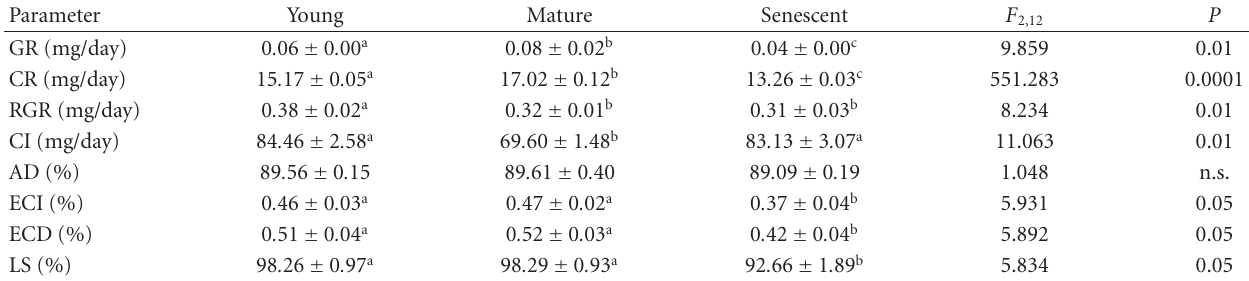
Table 2: Food utilization e ffi ciency measures of first instar larva of D. casignetum reared on young, mature and senescent sunflower leaves. Parameter